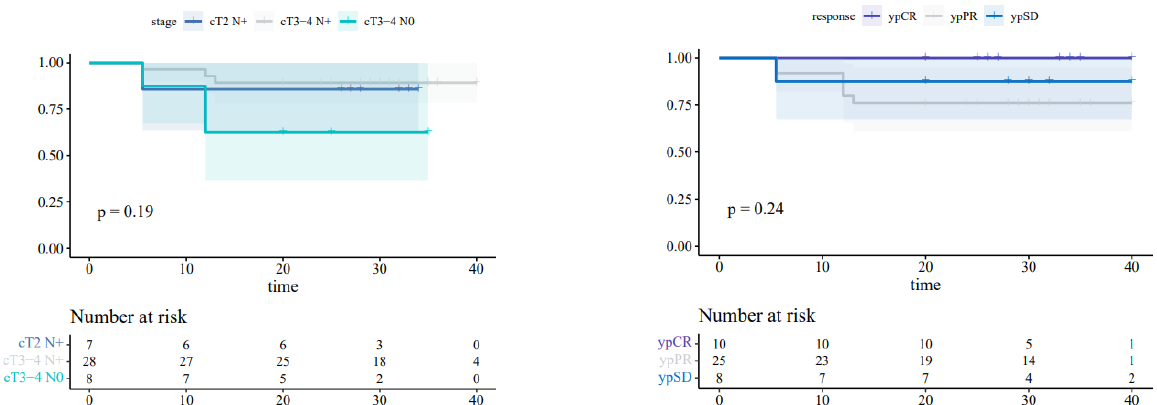
Figure 3. Kaplan – Meier curves showing DFS rates comparing different risk groups (cTNM, pato- Figure 3. Kaplan–Meier curves showing DFS rates comparing different risk groups (cTNM, patologi- logical response after neoadjuvant therapy). cal response after neoadjuvant